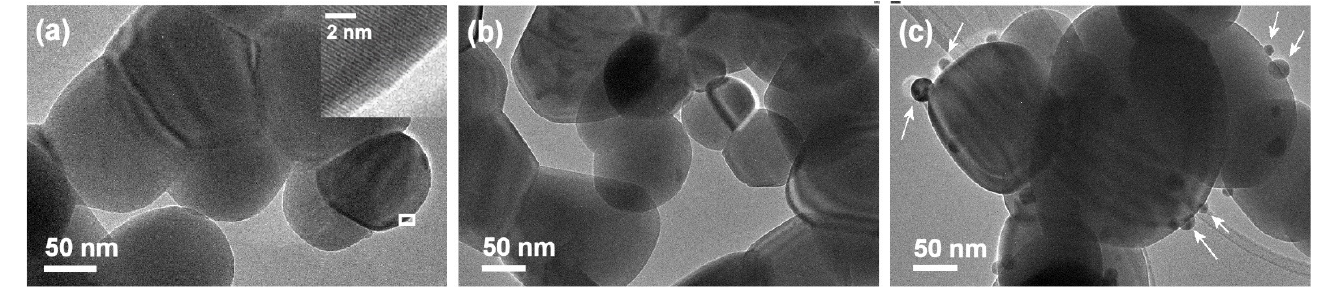
Figure 5. TEM images of ( a ) ZnO pure, ( b ) Ag/ZnO (I), and ( c ) Ag/ZnO (II). The white rectangle in the ( a ) defines the area of the inset. Arrows in the image ( c ) point toward Ag nanoparticles.